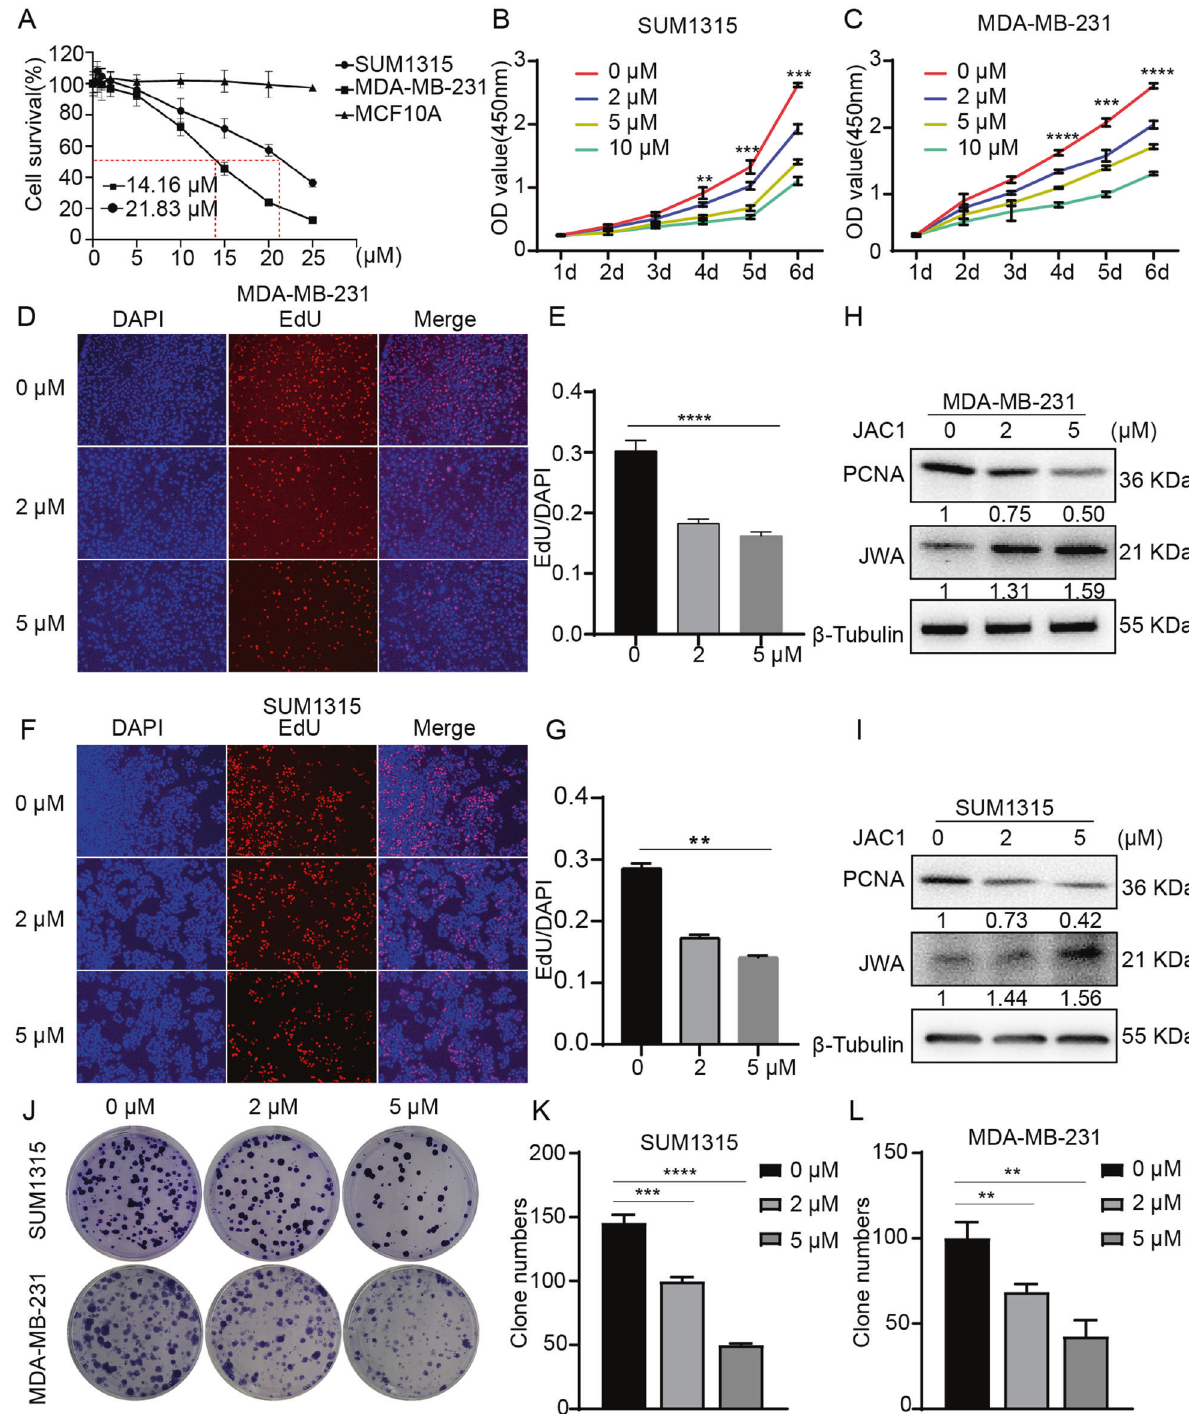
Fig. 2 JAC1 inhibits the proliferation of TNBC cells. A Viabilities of MDA-MB-231, SUM1315, and MCF10A cells were analyzed by CCK8 after treated by different doses of JAC1 for 24 h ( n = 5). Viability of SUM1315 cells ( B ) and MDA-MB-231 cells ( C ) were analyzed by CCK8 in 6 days ( n = 5). D , E EdU assay of MDA-MB-231 cells was performed to evaluate cell proliferation after treated by different doses of JAC1 for 24 h (magni fi cation, ×50, scale bar, 50 μ m), ( n = 3). F , G EdU assay of SUM1315 cells was performed to evaluate cell proliferation after treated by different doses of JAC1 for 24 h (magni fi cation, ×50, scale bar, 50 μ m), ( n = 3). The expressions of PCNA protein in MDA-MB-231 ( H ) and SUM1315 ( I ) cells were measured by Western blot after treated with 0, 2, 5 μ M JAC1 for 24 h. J Colony formation assays were completed for MDA-MB-231 and SUM1315 cells treated by JAC1 (0, 2, 5 μ M). The quantitative data of colony numbers of SUM1315 ( K ) and MDA-MB-231 ( L ) cells ( n = 3). * P < 0.05, ** P < 0.01, *** P < 0.001, **** P < 0.0001. N.S. no signi fi cant